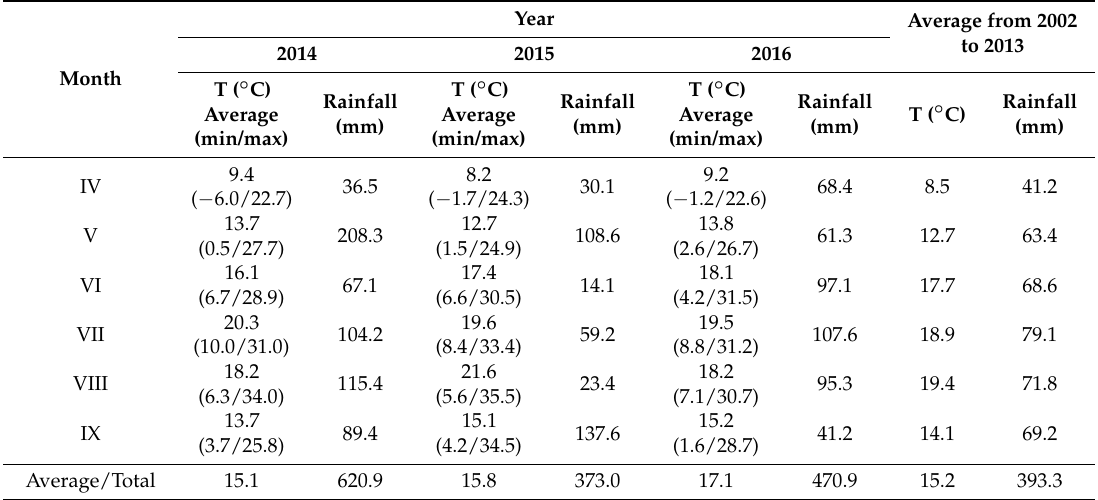
Table 2. Temperature (T) and rainfalls during the soybean growing season